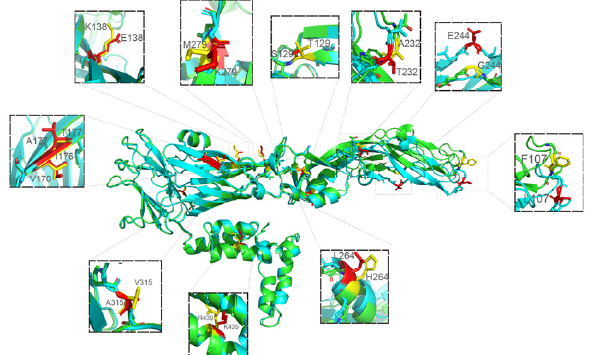
Figure 9. Display and comparison of modeled 3D structures between JEV CH/GD2015/2015 and CH/SA14-14-2 MSV/2018. The difference sites were at 107, 129, 138, 176, 177, 232, 244, 264, 279, 315 and 439 amino acids (green is the modeled 3D structures of vaccine strain; blue is the modeled 3D structures of CH/GD2015/2015; the different amino acids are distinguished by yellow and red: yellow for CH/SA14-14-2 MSV/2018 and red for CH/GD2015/2015.).